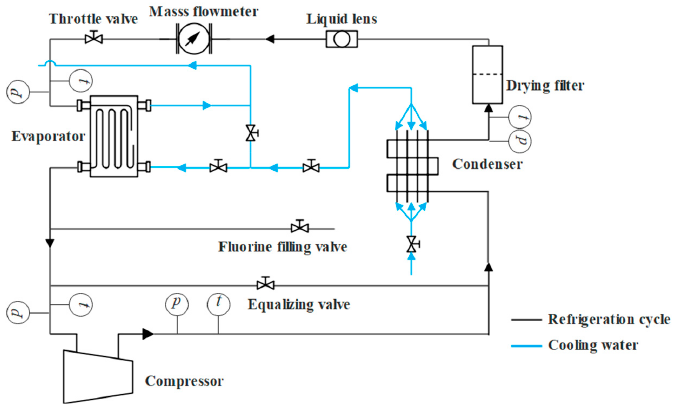
Figure 4. The performance experiment flow diagram.